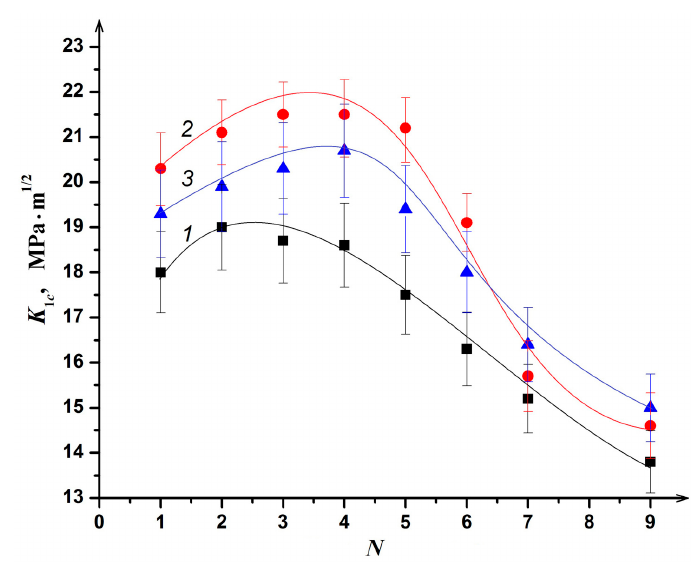
Figure 9. Crack resistance behavior of the materials subjected to HPT: 1 –Fe 53.3 Ni 26.5 B 20.2 AA; 2 –Co 28.2 Fe 38.9 С r 15.4 Si 0.3 B 17.2 AA; 3 –composite.